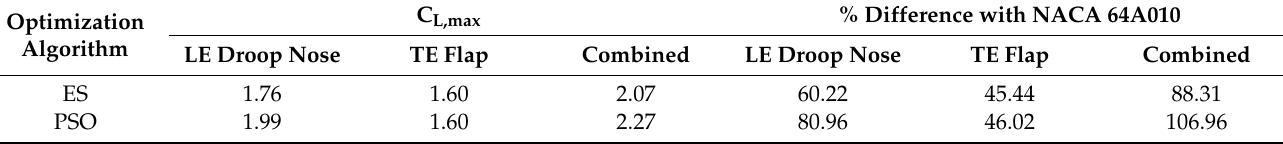
Figure 11. Effects of the individual LE droop nose and TE flap morphing and their combination on the lift coefficient polar. ES algorithm with eight generations (1008 evaluations) was employed for the individual as well as the combined morphing optimization. Flow simulations were performed using Foil2w. Measurements for extended and drooped slat are reported in [28]. Percentages of C L,max increase for the individual LE droop nose and TE flap, as well Table 5. Relative increase in CL,max applying optimized LE droop noose, TE flap, and combined morphing with the PSO as for the combined morphing are summarized inTable 5. The C L,max increase with respect and ES algorithms. Simulation of the flow field was performed by to the reference deformation airfoil (combined morphing) is 23.5% and 12.3% for the PSO and ES airfoils, respectively.